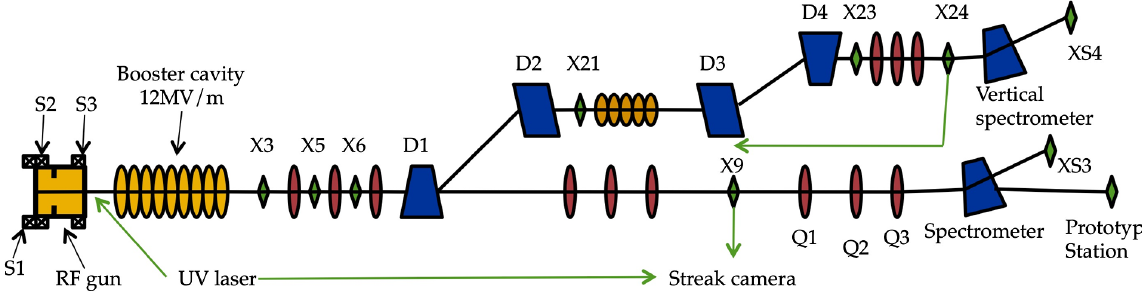
FIG. 1. A schematic of the A0 photoinjector test area showing the PC rf gun, nine-cell booster cavity, transverse emittance stations, and the OTR stations. The X5 and prototype station locations are indicated.